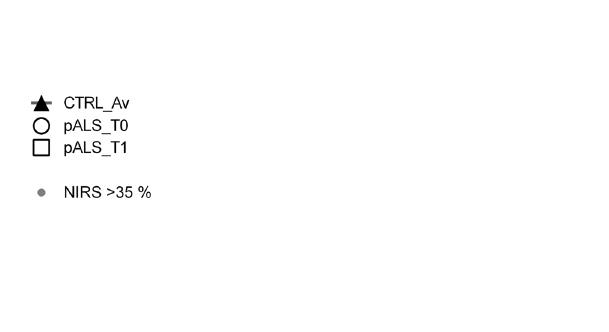
Figure 1. Correlation between exercise tolerance (  V O 2peak ) and vastus lateralis O 2 extraction at peak of exercise ( Δ [HHb]/ Δ [HHb]isch), in pALS (black line) and CTRL (broken line, not significant). White circles: pALS at baseline (T0); white squares: pALS after 4 months (T1); grey triangles: matched healthy CTRL.